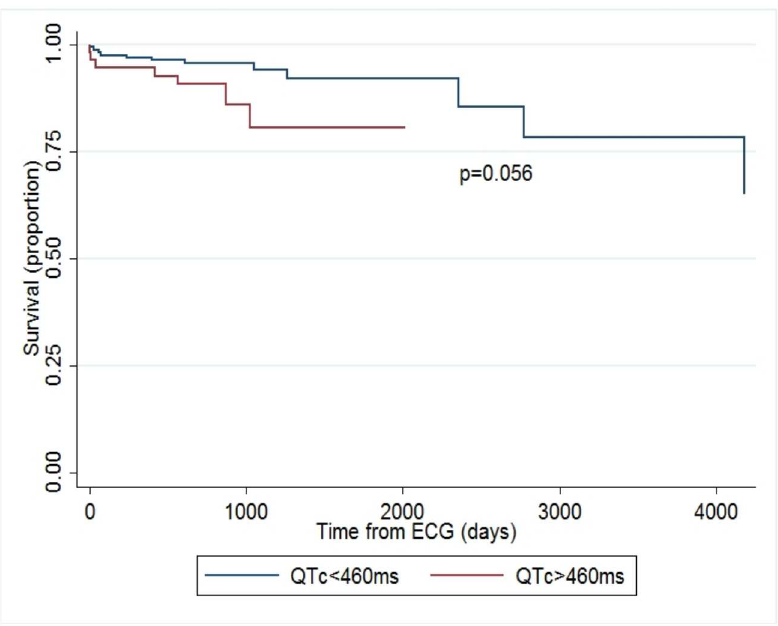
Fig 1. Kaplan-Meier survival curve, QTc of 460ms. Kaplan-Meier survival curves from time of ECG acquisition at the 75 th percentileof QTc (460ms) in the UIC